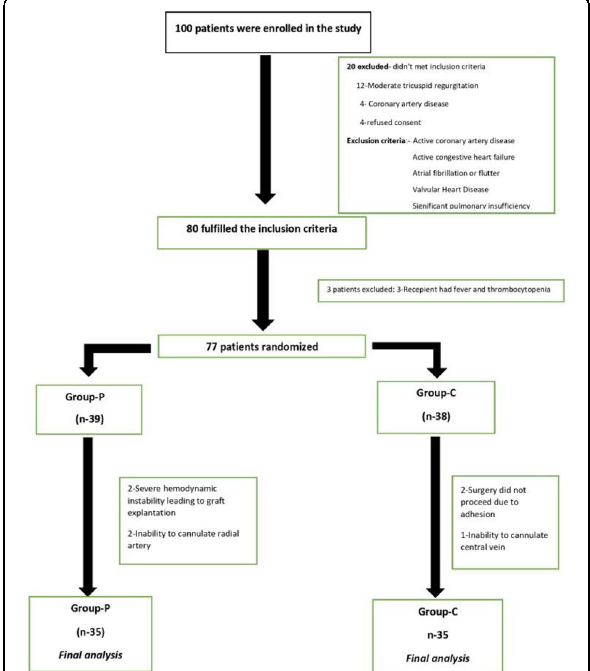
Fig. 1 (abstract 000194). CONSORT flow diagram of the randomised trial of two